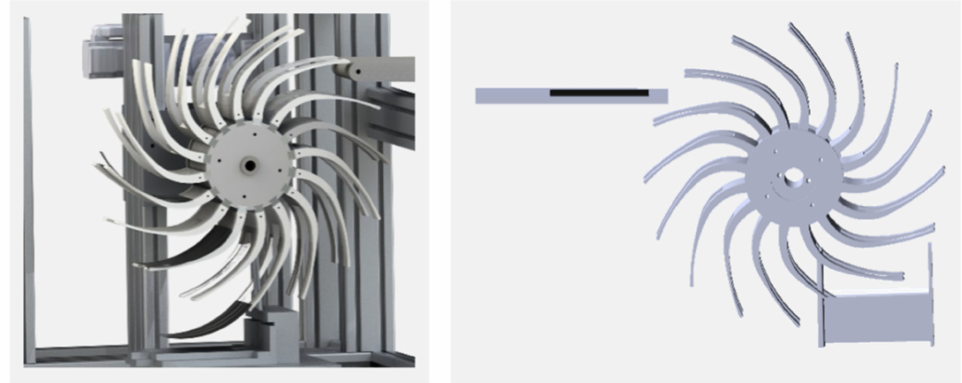
Figure 11. CAD model ( left ) and simplified simulation model ( right